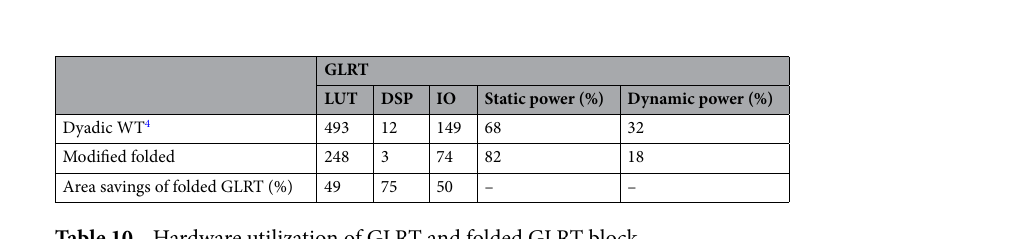
Table 10. Hardware utilization of GLRT and folded GLRT